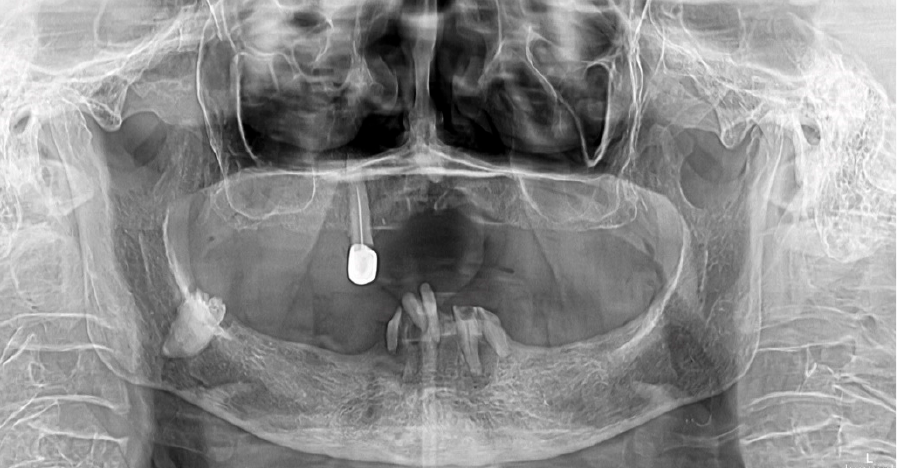
Figure 3. X-ray panoramic image of the 88-year-old female patient, showing the presence of the molar 48 included in a vertical position.